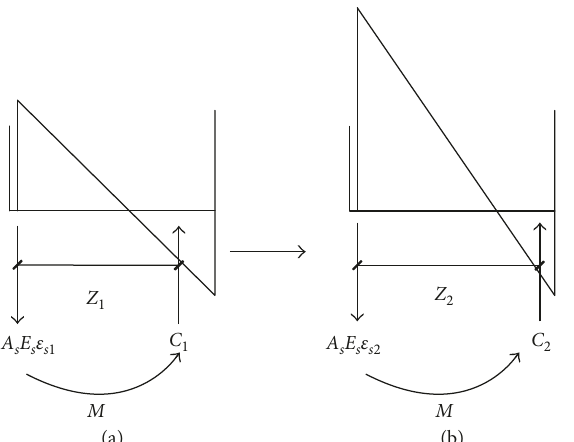
Figure 2: Force in (a) bonded cross section and (b) unbonded cross section. Note: C concrete, respectively.